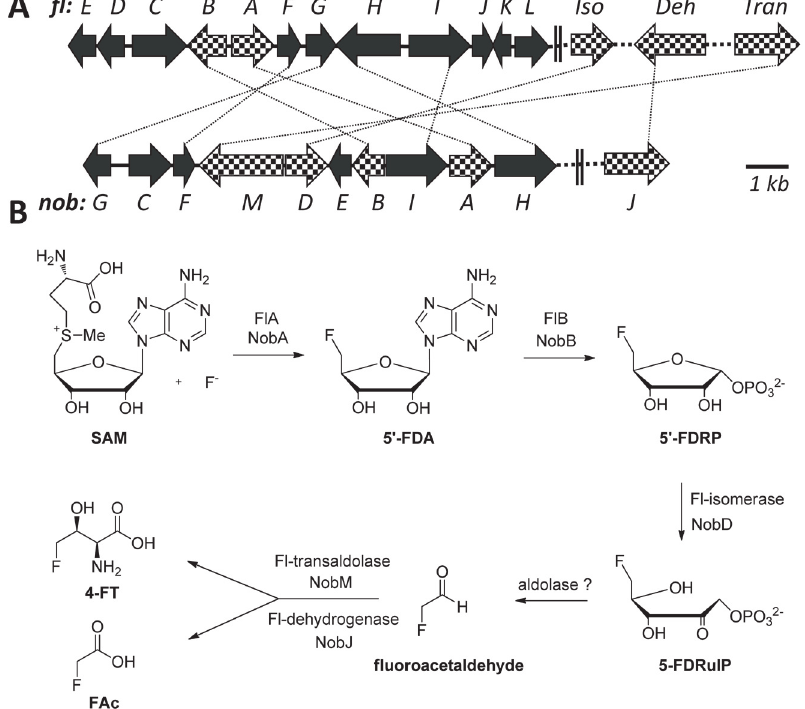
Figure 1. Biosynthetic genes and pathways for FAc and 4-FT biosynthesis. ( A ) Organization of relevant genes in the fl and nob pathway, encoding the conversion of fluoride to FAc and 4-FT (crosshatched), and auxiliary function (blackened). Iso: isomerase; Deh: dehydrogenase and Tran: transaldolase. Identical genes are indicated by dotted lines. ( B ) Proposed biosynthetic pathways to the FAc and 4-FT in the S. cattleya and N. brasiliensis